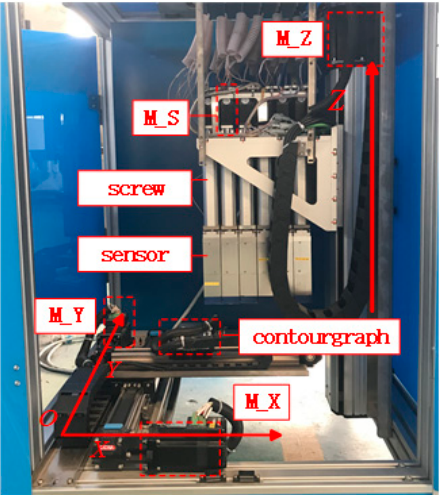
Figure 14. Schematic diagram of the system.